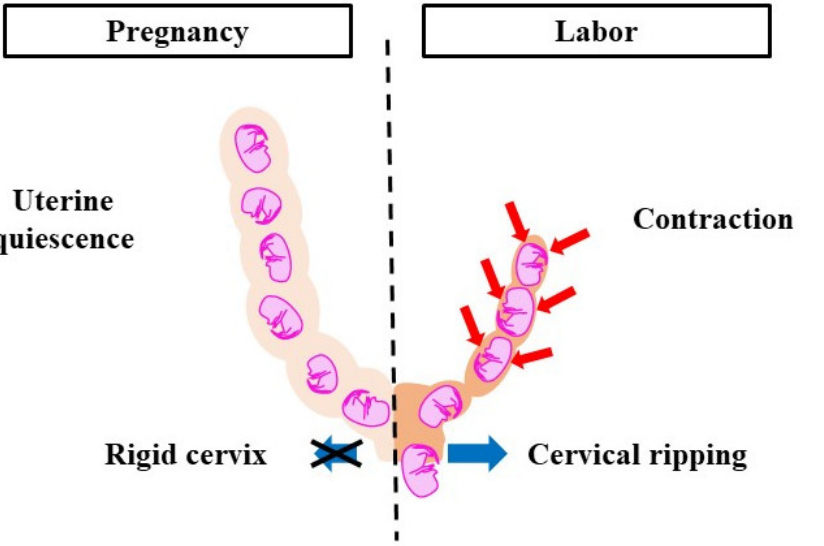
Figure 1. Pregnancy-maintenance mechanism and labor-induction mechanism. During pregnancy, uterine contractions do not occur and the cervical canal is immature. During labor, uterine contractions are activated and cervical ripening is promoted. To deliver at term, the pregnancy-maintenance mechanism and labor-induction mechanism need to work at the right time. Red arrows: contraction, blue arrows: cervical dilation